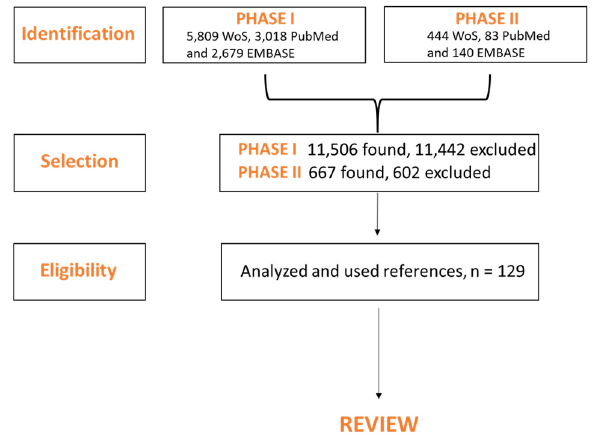
Figure 6. Flowchart of choice of articles for review, “Silver Nanoparticles for Wound Dressing